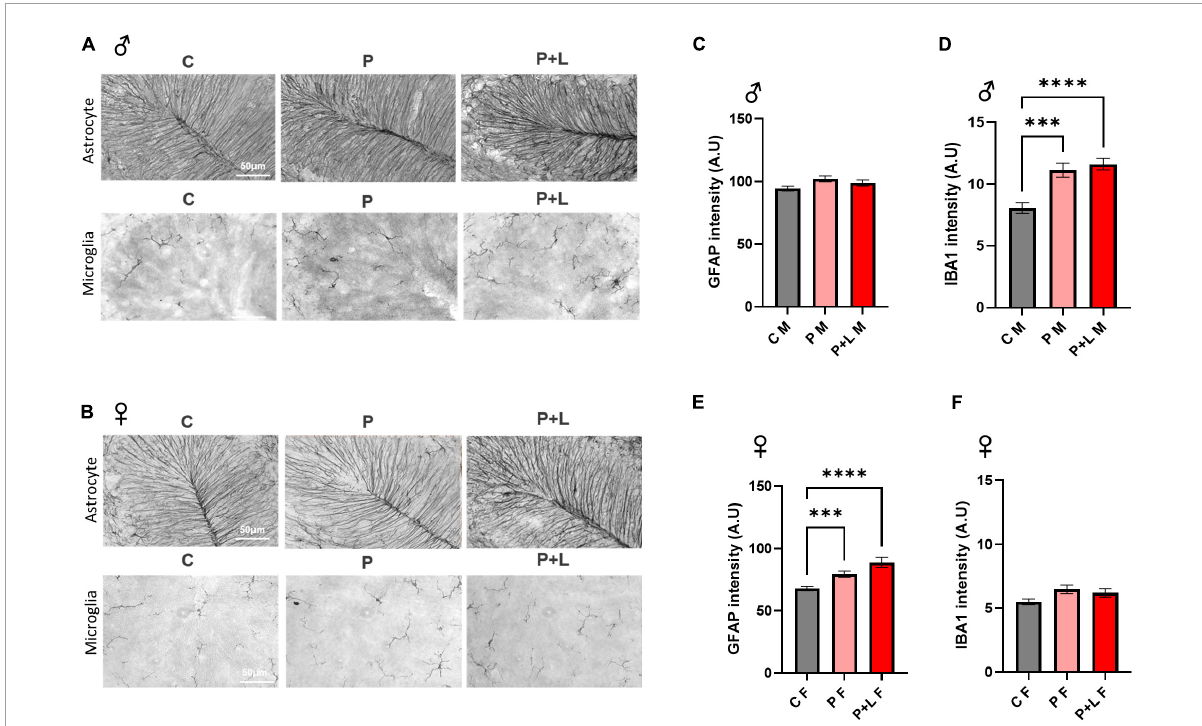
FIGURE4 Induced gliosis in lead exposed mouse offspring cerebellum. (A,B) Representative images of DAB immunohistochemistry in offspring cerebellum. Scale bars, 50 µ m. (C,E) Statistic analysis of astrocytic GFAP intensity. Data were analyzed with one-way ANOVA, expressed as mean ± SEM. (D,F) Statistic analysis of microglial IBA1 intensity. Data were analyzed with one-way ANOVA, expressed as mean ± SEM. (C) Result of GFAP intensity in male offspring. Any change of intensity was not shown. N = 3 per group. (D) Result of IBA1 intensity in male offspring. Lead-exposed groups were significantly increased. N = 3 per group, ∗∗∗ p < 0.001, ∗∗∗∗ p < 0.0001. (E) Result of GFAP intensity of female offspring. P, P + L groups were significantly increased. N = 3 per group, ∗∗∗ p < 0.001, ∗∗∗∗ p < 0.0001. (F) Result of IBA1 intensity of female offspring. Any change was not shown. N = 3 per